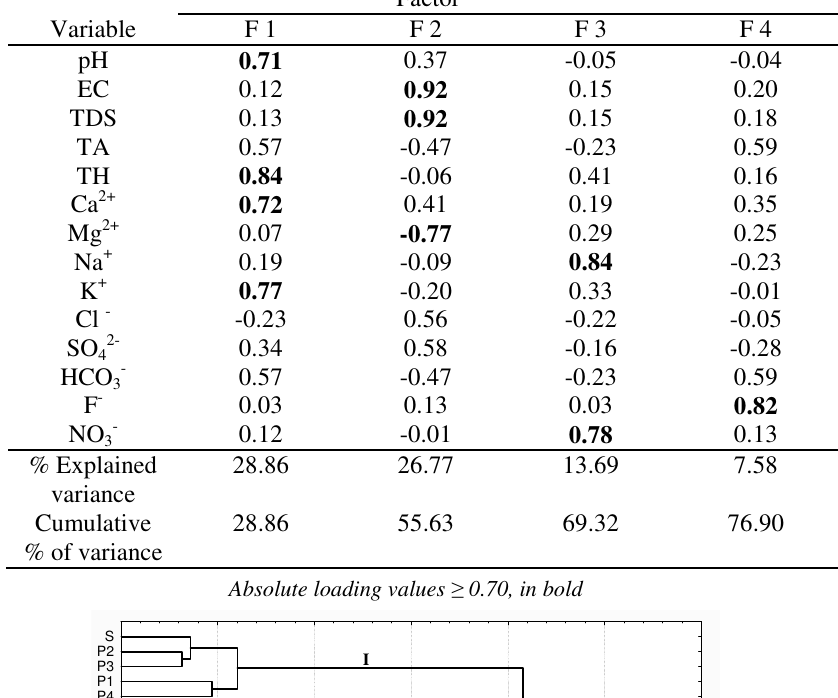
Table 4. Varimax rotated factor loading matrix for wells water chemistry data in rainy season.